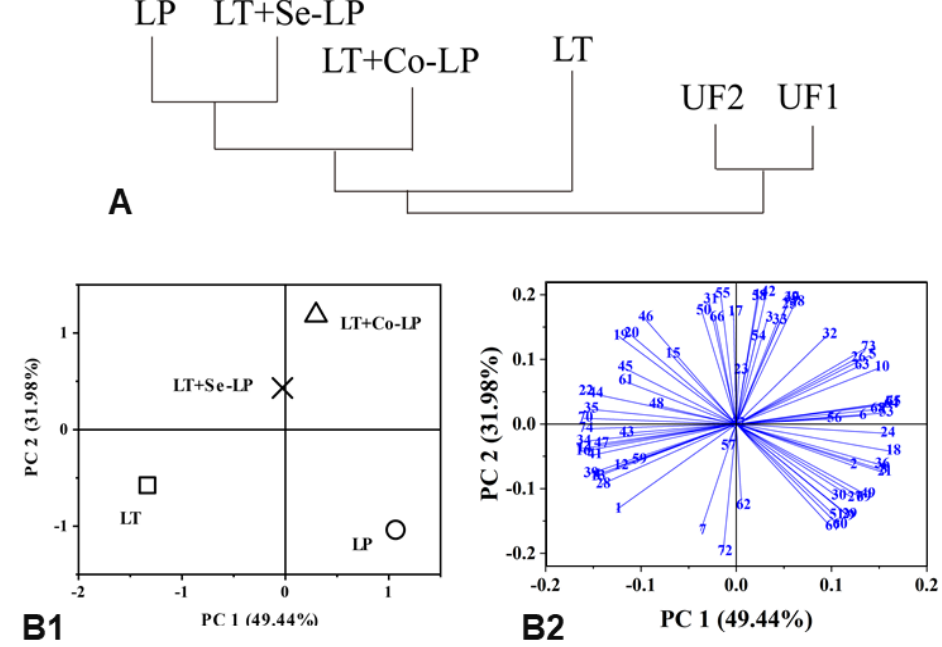
Figure 7. Cluster relationship ( A ) and PCA analysis of volatile profiles ( B ) of SCG hydrolysates fermented with L. thermotolerans Concerto and L. plantarum ML Prime. UF1 and UF2: Unfermented SCG hydrolysates at D0 and D14; LT ( □ ): L. thermotolerans Concerto; LP ( ○ ): L. plantarum ML Prime; LT+Co-LP ( (cid:52) ): simultaneous inoculation of L. thermotolerans Concerto and L. plantarum ML Prime; LT+Se-LP (X): L. thermotolerans Concerto with sequentially inoculated L. plantarum ML Prime at day 4. The compound names (1-72) were listed in Table